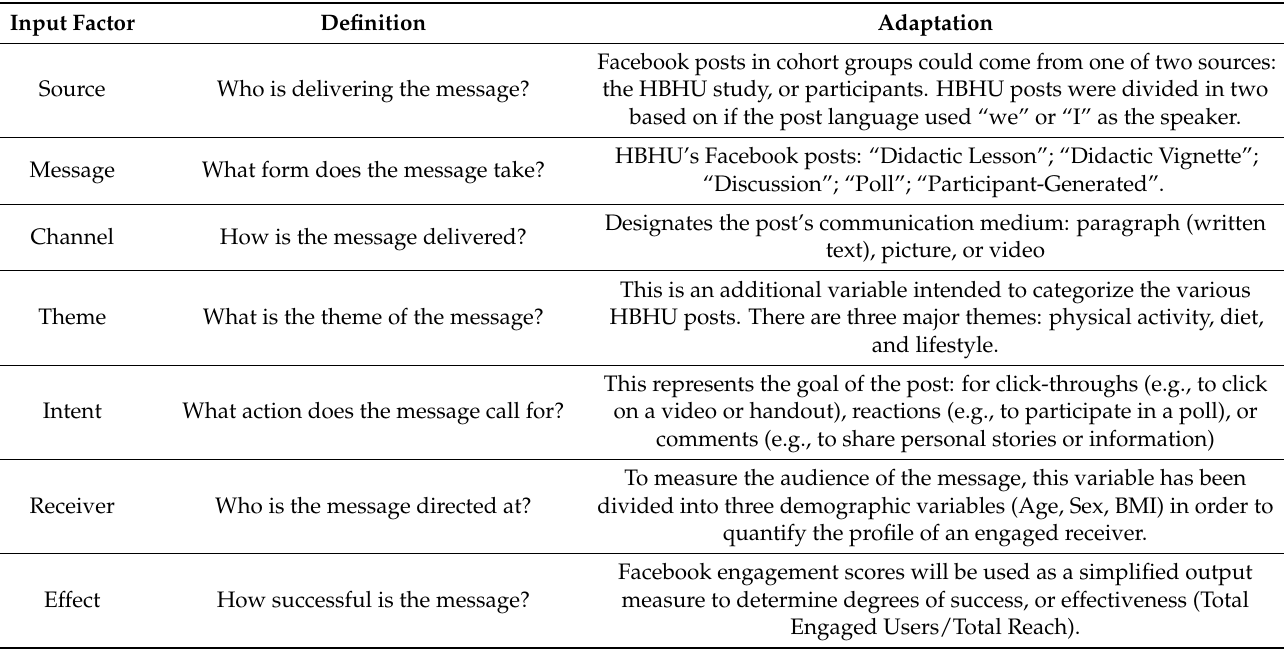
Table 1. Adaptation of McGuire’s Model of Communication and Persuasion